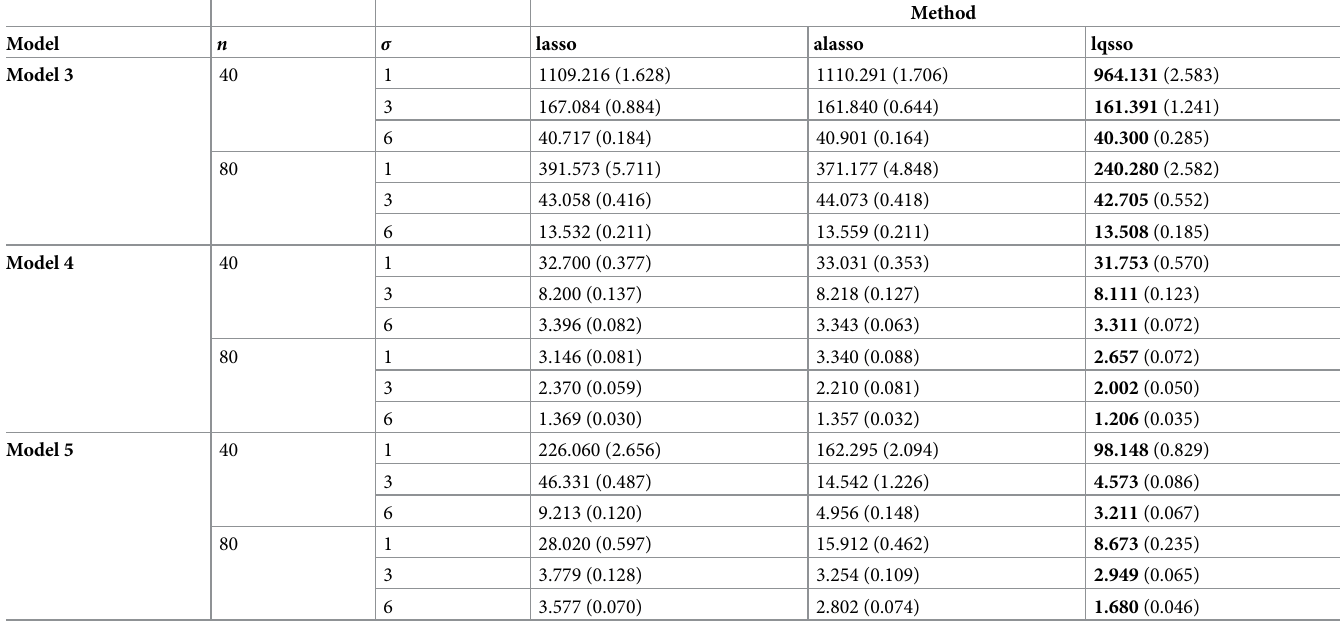
Table 3. The mean values of RPEs for Model 3, Model 4 and Model 5.